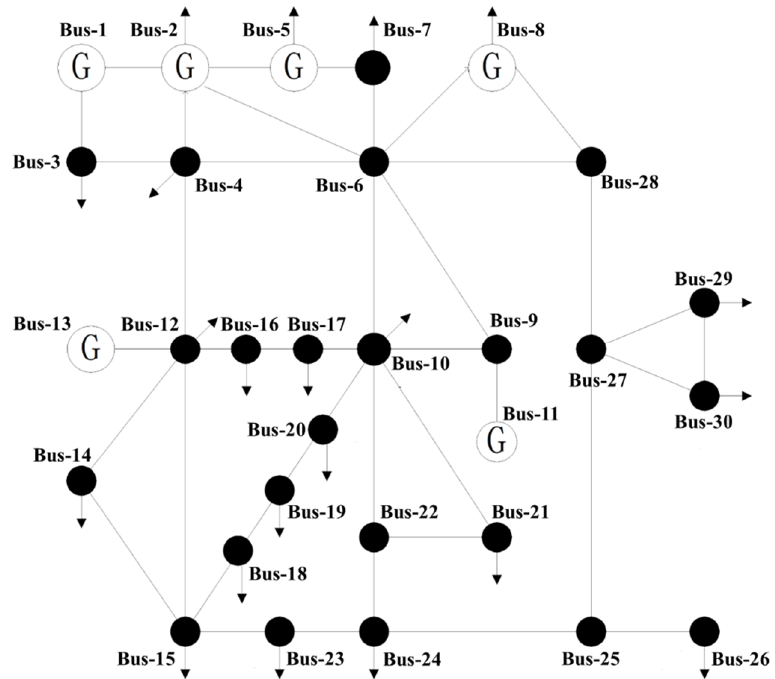
Figure 1. The network structure of the IEEE 30-bus system.